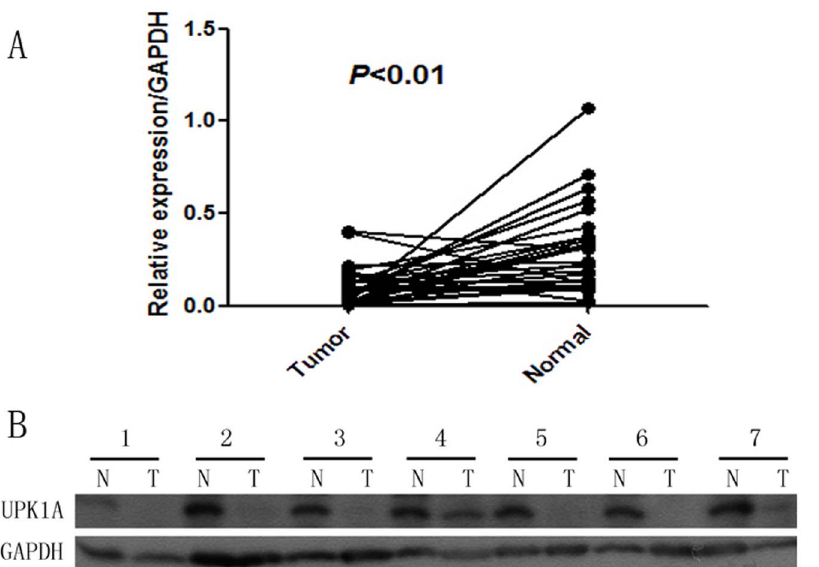
Figure 2. Decreased expression of UPK1A protein in GC tumor tissues was detected by western blotting (n=29, p , 0.01, gastric cancer tumor compared with tissue, Wilcoxon matched-pairs signed-rank test). (A) Expression of UPK1A protein in gastric tumor and adjacent non-tumor tissues. (B) The relative expression of UPK1A in comparison with the expression level of normal paracancerous tissues. (N, normal paracancerous tissues; T, tumor).